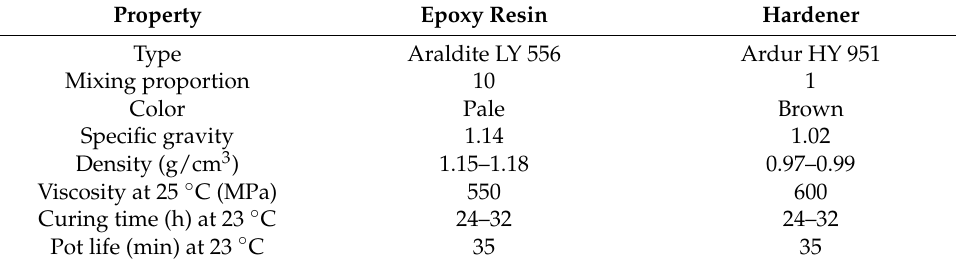
Table 3. The chemical and mechanical properties of Epoxy and Hardener